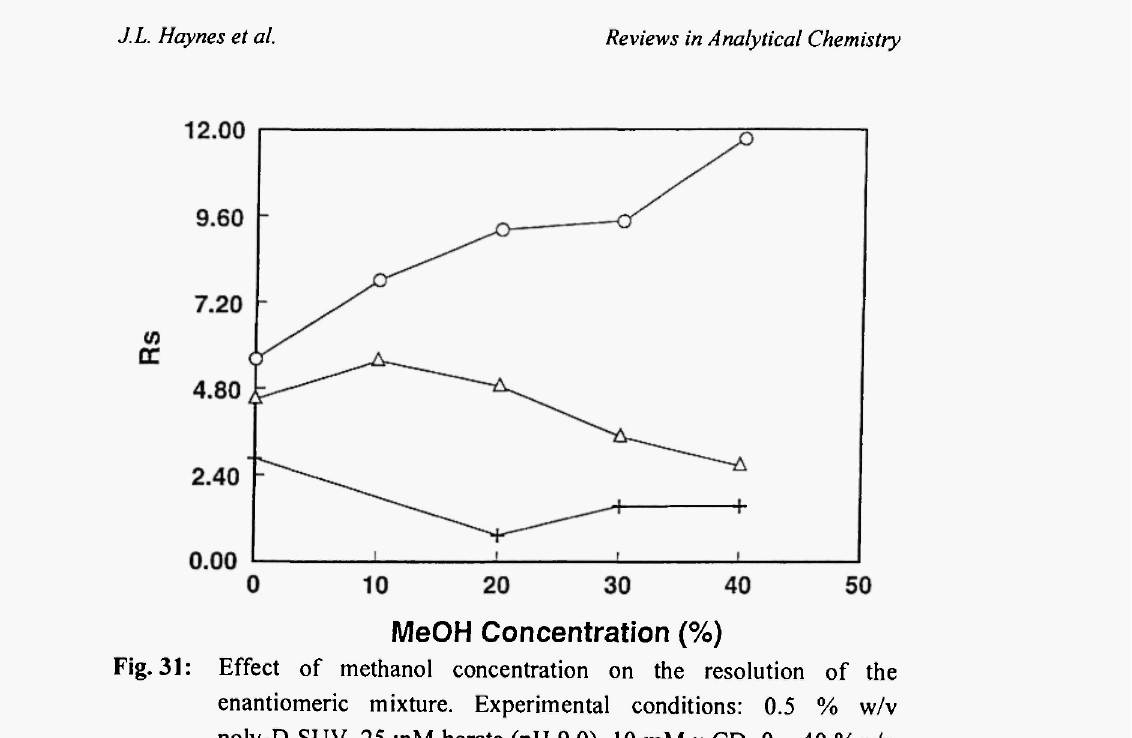
MeOH Concentration (%) Fig. 31: Effect of methanol concentration on the resolution of the enantiomeric mixture. Experimental conditions: 0.5 % w/v poly-D-SUV, 25 inM borate (pH 9.0), 10 raM γ-CD, 0 - 40 % v/v methanol; applied voltage, 12 kV; UV detection, 280 nm. ° = (±)-1,1 '-bi-2-naphthol, Δ = (±) - verapamil, + = (±)-1,Γ- binaphthyl-2,2'diyl hydrogen phosphate. From /35/ with